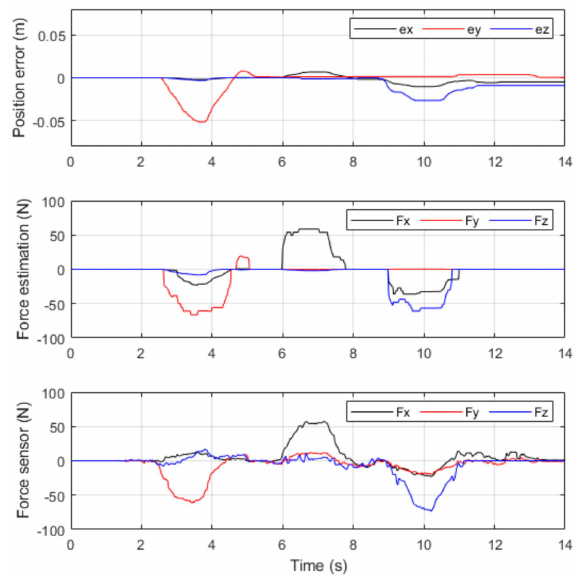
Figure 7. Contact force detection results.